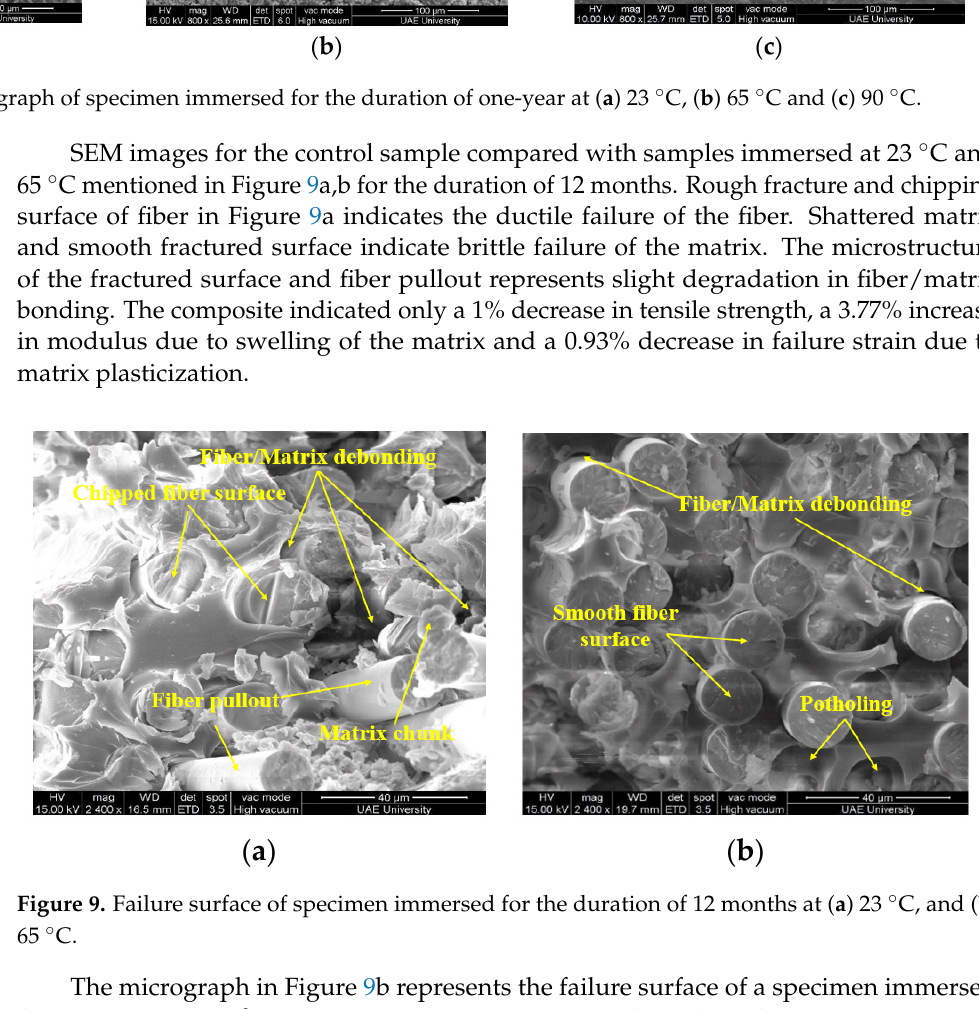
Figure 8. Surface micrograph of specimen immersed for the duration of one-year at ( a ) 23 °C, ( b ) 65 °C and ( c ) 90 °C.